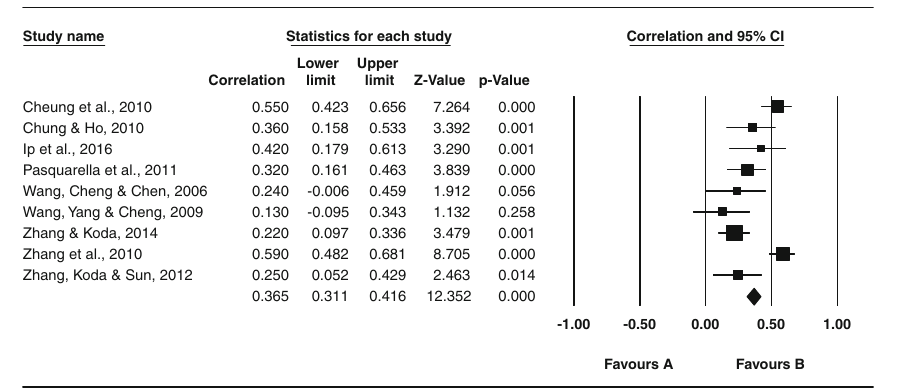
Fig. 5 Overall average correlation and correlation with confidence interval for each study correlating Chinese and English morphological awareness. Note. Overall correlation shows at the bottom of the figure. Diamond shape = overall correlation average across listed studies on graph. Size of square reflects sample size, with bigger square representing a larger sample size (Cheung et al., 2010; Chung & Ho 2010; Ip et al., 2016; Pasquarella et al., 2011; Wang, Cheng & Chen 2006; Wang, Yang & Cheng 2009; Zhang & Koda 2014; Zhang et al., 2010; Zhang, Koda & Sun 2012)